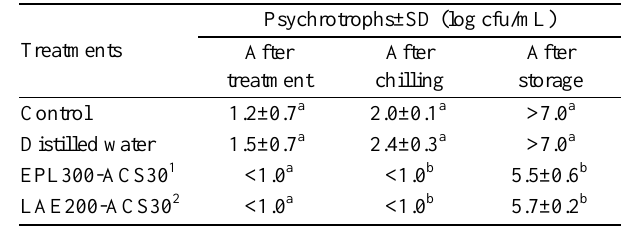
Table 5. Mean counts of psychrotrophs on chicken carcasses after spray treatment with distilled water, EPL300-ACS30 or LAE200- ACS30, after chilling and after 10 days of storage at 4.4°C